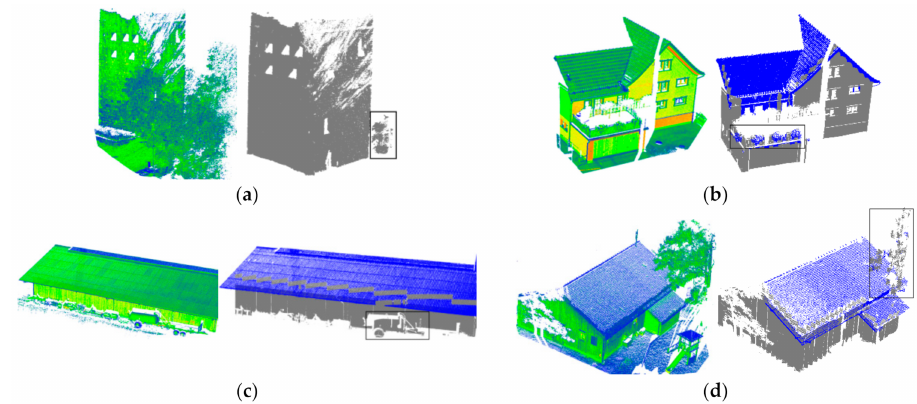
Figure 19. Different types of FP errors with falsely extracted points marked in the rectangle. ( a , b ) show the case that non-building points are located in a facade cell; ( c , d ) show the case of vertical overlap of building and non-building points. For each sub-figure, the left side shows the original points rendered by intensity and the right side shows the result of DoPP filtering (gray) and roof detection